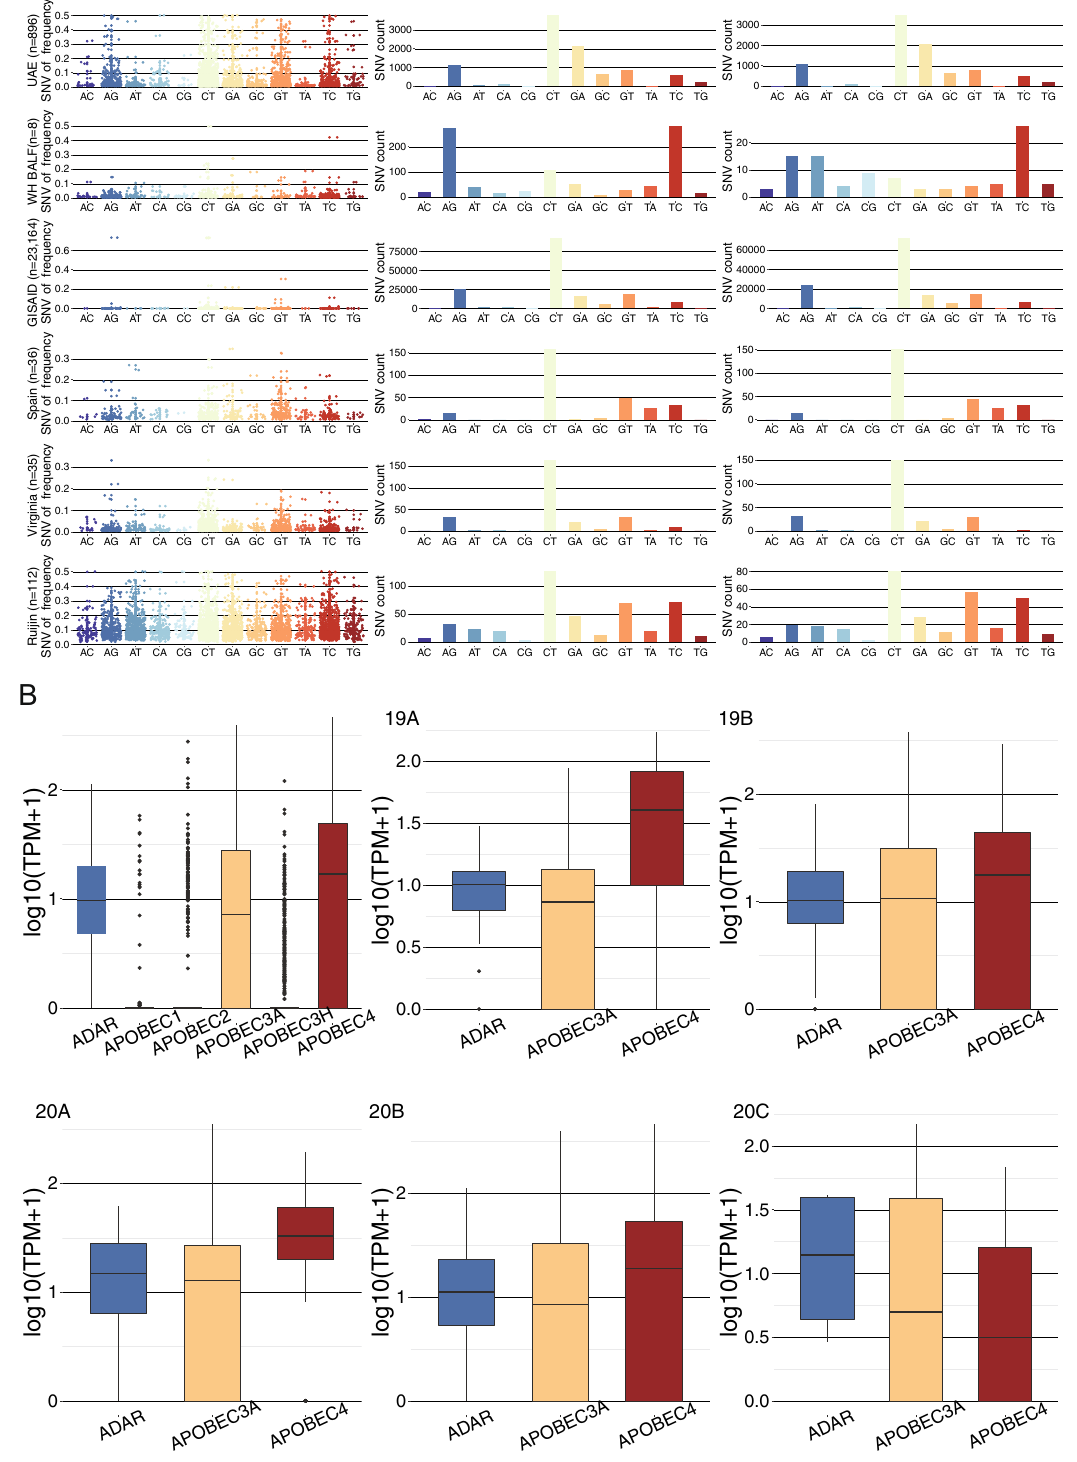
Figure 6. Human innate immune response to SARS-CoV-2 mediated by the ADAR and APOBEC gene families. ( A ) Allelic faction (Column 1), the number of mutations (Column 2) and the number of recurrent mutations (Column 3) for twelve mutation types for six studies arranged by row. UAE: 896 nasal swab samples collected in our study; GISAID: 23,164 viral sequences collected; Spain: 36 nasal swab samples collected in Spain; Virginia: 35 nasal swab samples collected in Virginia and 112 nasal swab samples collected in Ruijin hospital in Shanghai city, China. ( B ) Host ADAR and APOBEC gene expression (logarithm of transcript per million) in the nasal swab samples for all and for each of the five